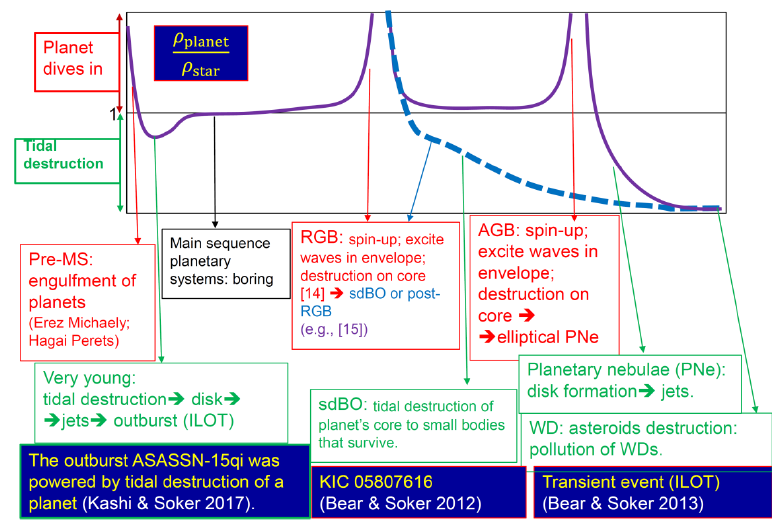
Figure 3. Outcomes of planet–star interaction.